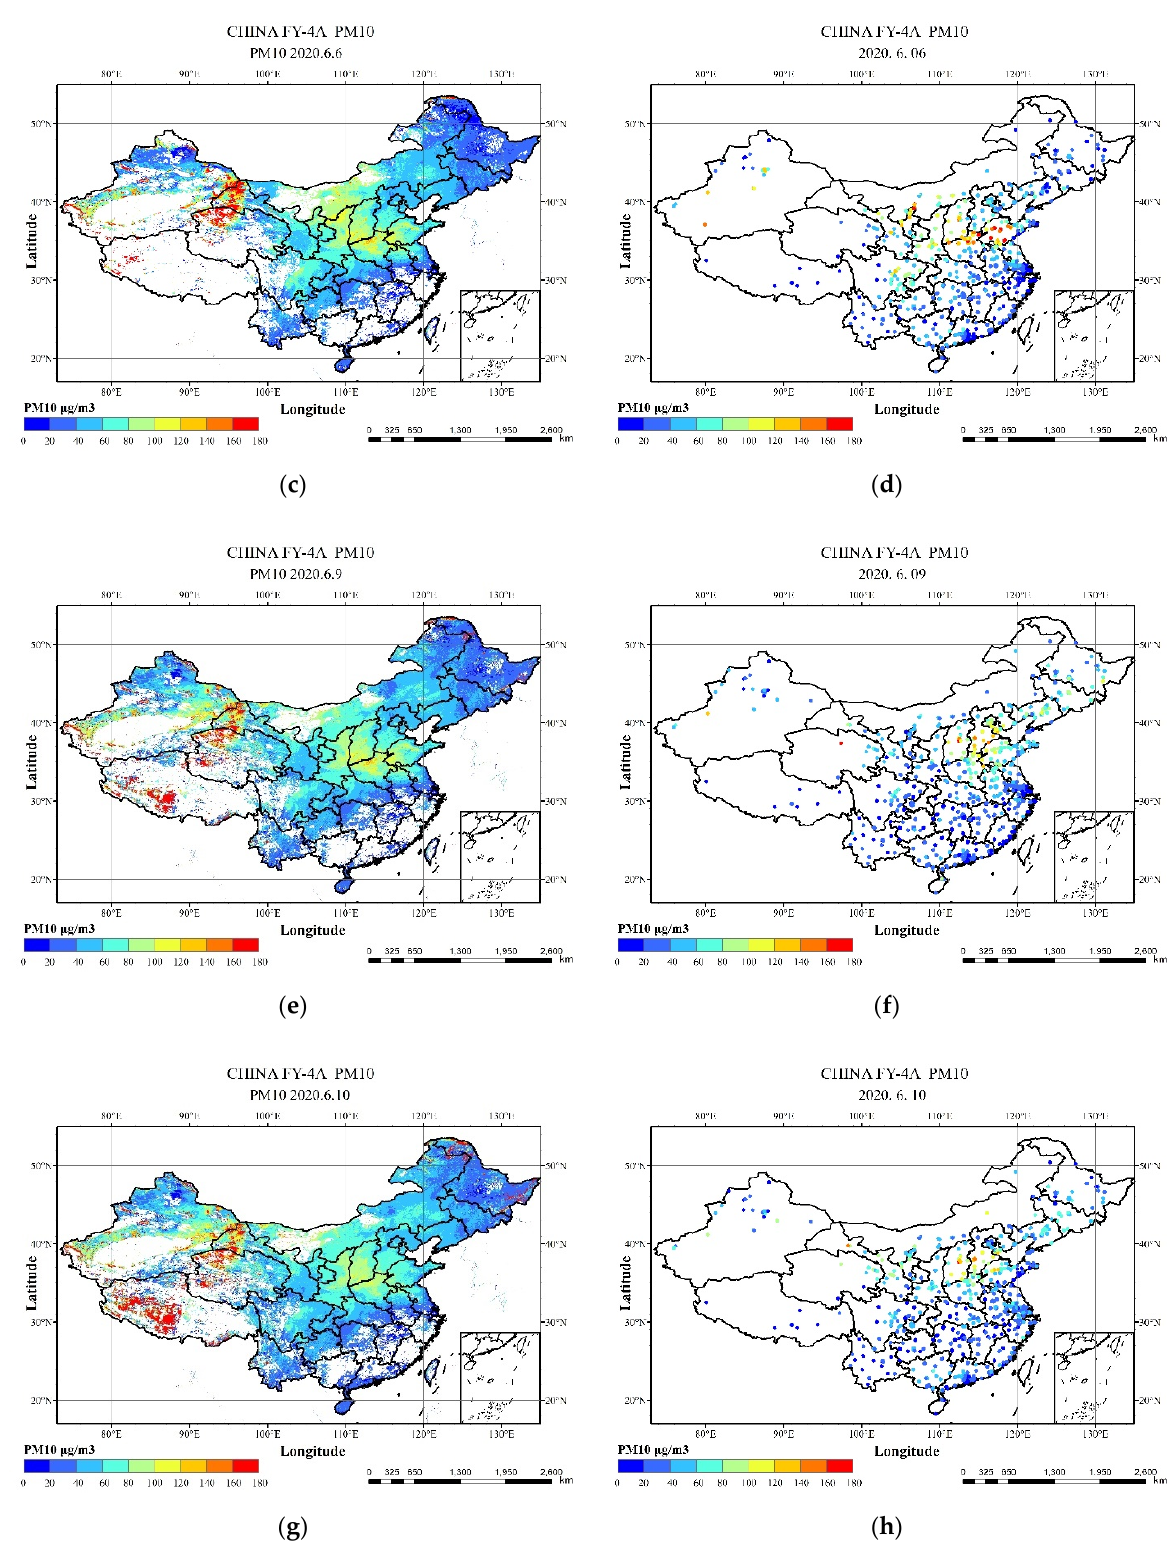
Figure 8. Average daily PM 10 concentration on 5–6 and 9–10 June 2020. Column 1 from ( a ) to ( d ) is model estimates and column 2 from ( e ) to ( h ) is station observations (columns 1 and 2, from left to right).